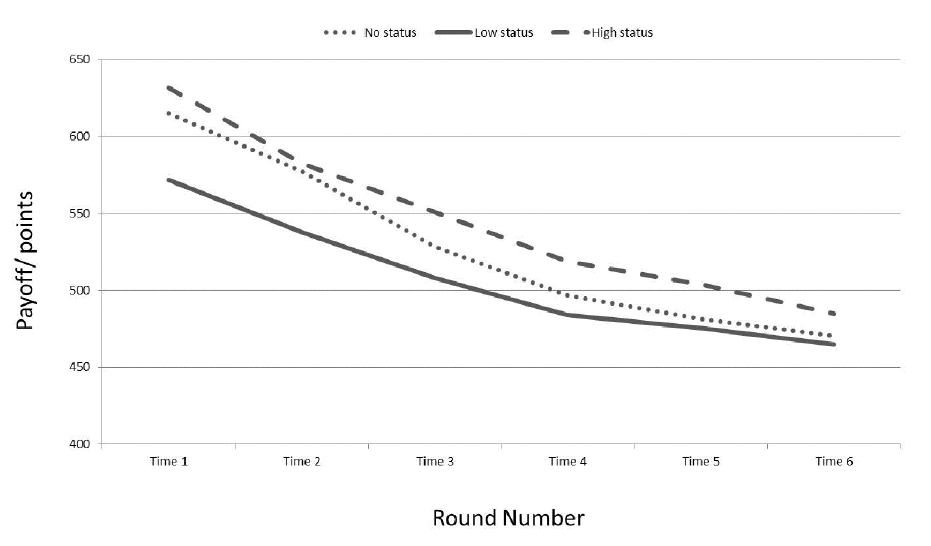
Figure 3. The effect of negotiator’s social power participant’s offer over the course of negotiation